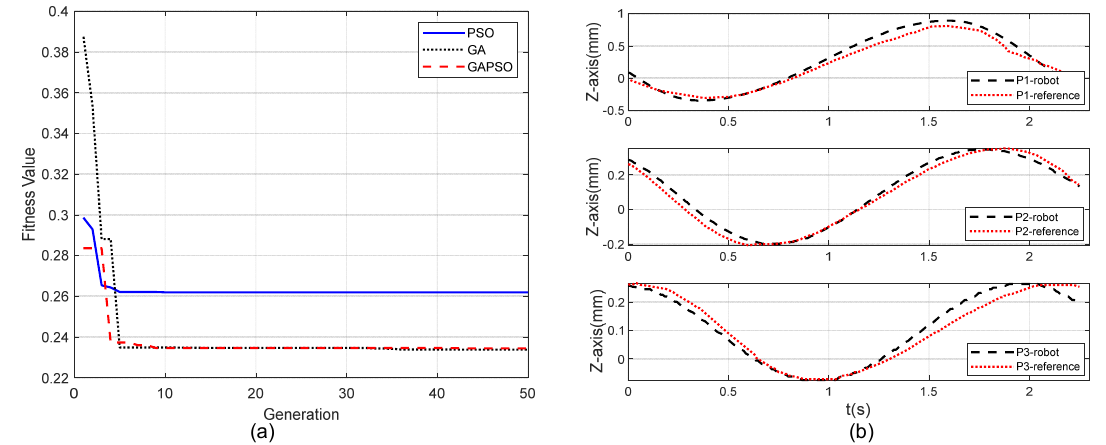
Figure 10. Simulation results of CPG network parameters after optimization. ( a ) Iterative results of GA, PSO, and GAPSO optimal individual fitness values graph; ( b ) CPG optimized result graph.